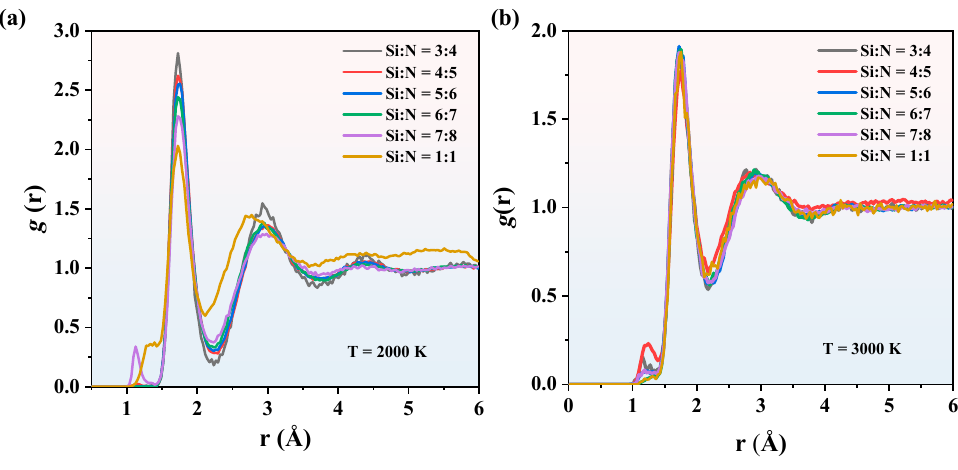
Figure 8. The RDFs of SiN x at ( a ) 2000 K and ( b ) 3000 K.